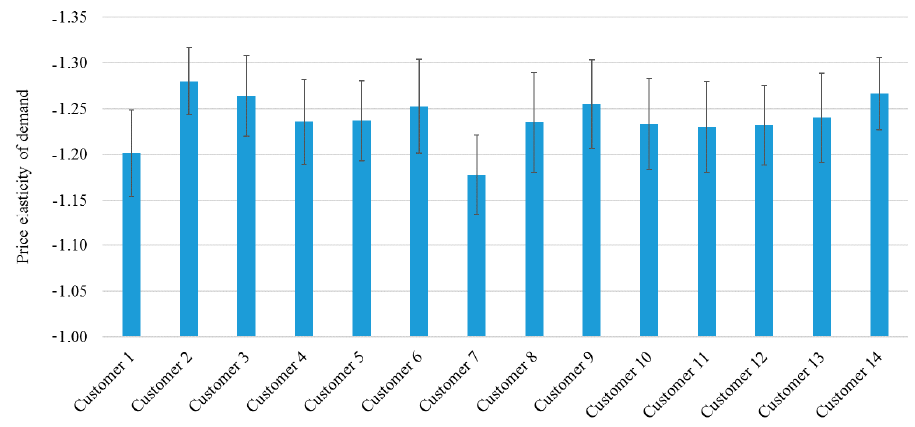
Figure 8. Average hourly price elasticity of demand for each customer group.